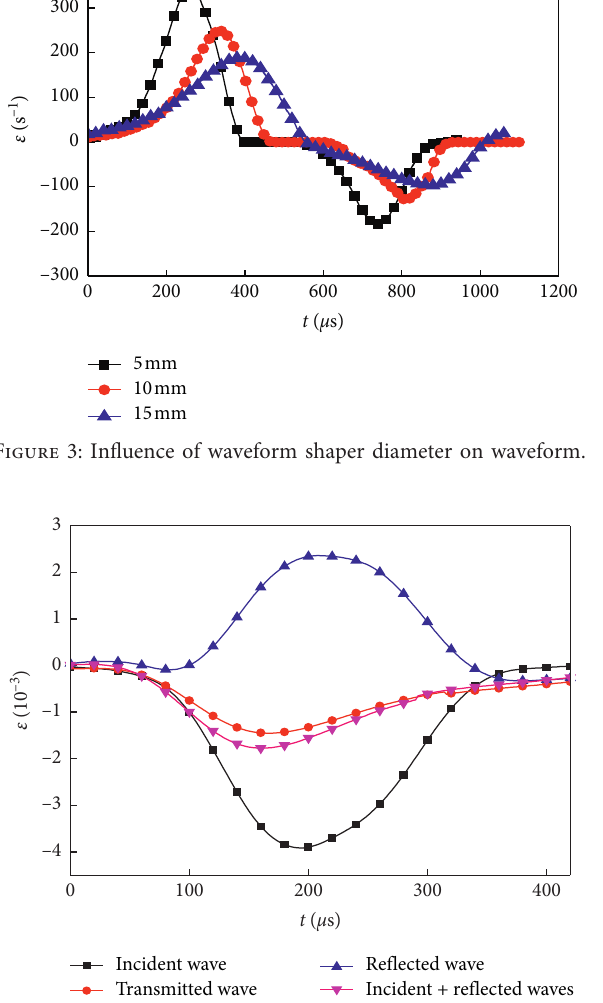
Figure 4: Typical waveform of the SHPB results of the